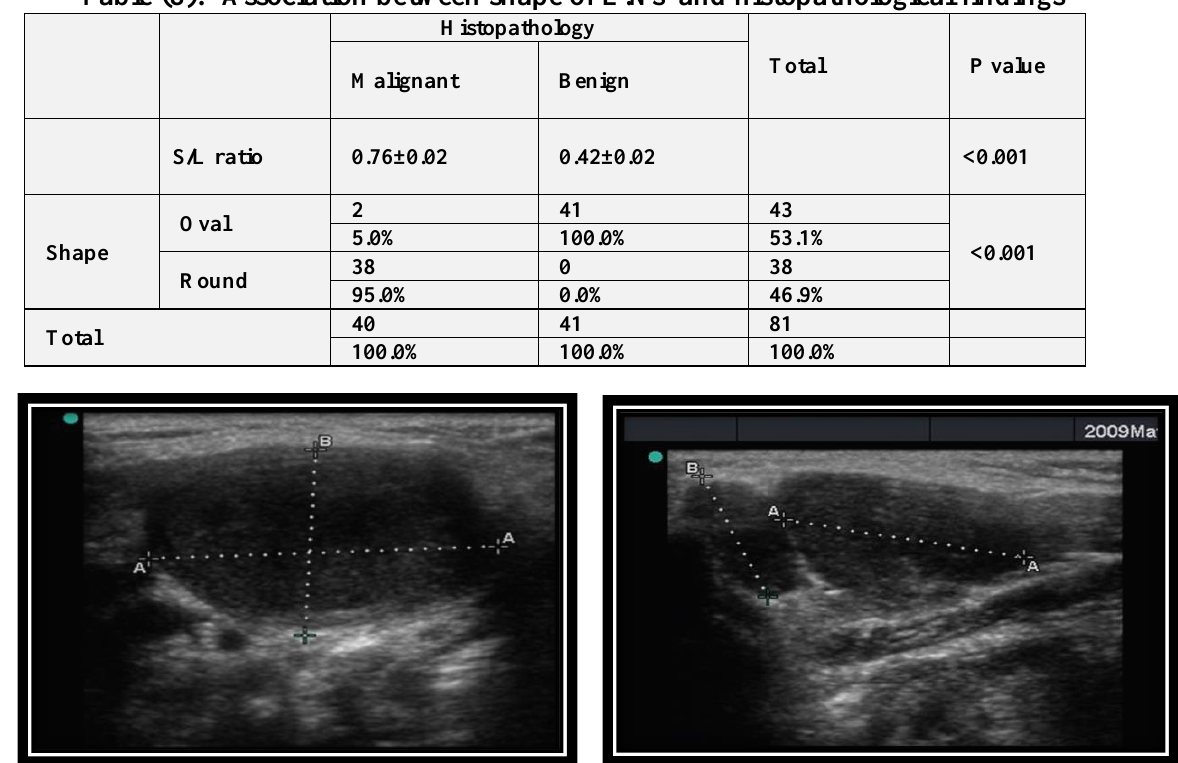
Figure (1):-Gray scale ultrasound image of Figure (2):-Gray scale ultrasound image Round-shaped malignant lymph node of oval-shaped reactive lymph node 3- The number of L.Ns: In this study the number of lymph nodes was classify to solitary (1-5) nodes, and diffuse (5-10) and the largest node was measured. Solitary nodes seen in (38 malignant and 39 benign), while diffuse